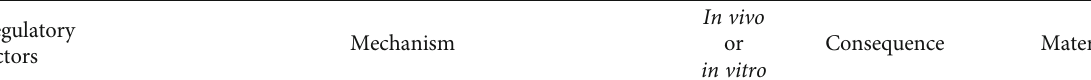
Table 4: ncRNAs in MSC aging and related